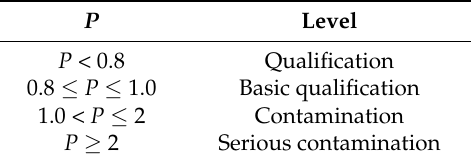
Table 1. Water quality classification based on comprehensive pollution